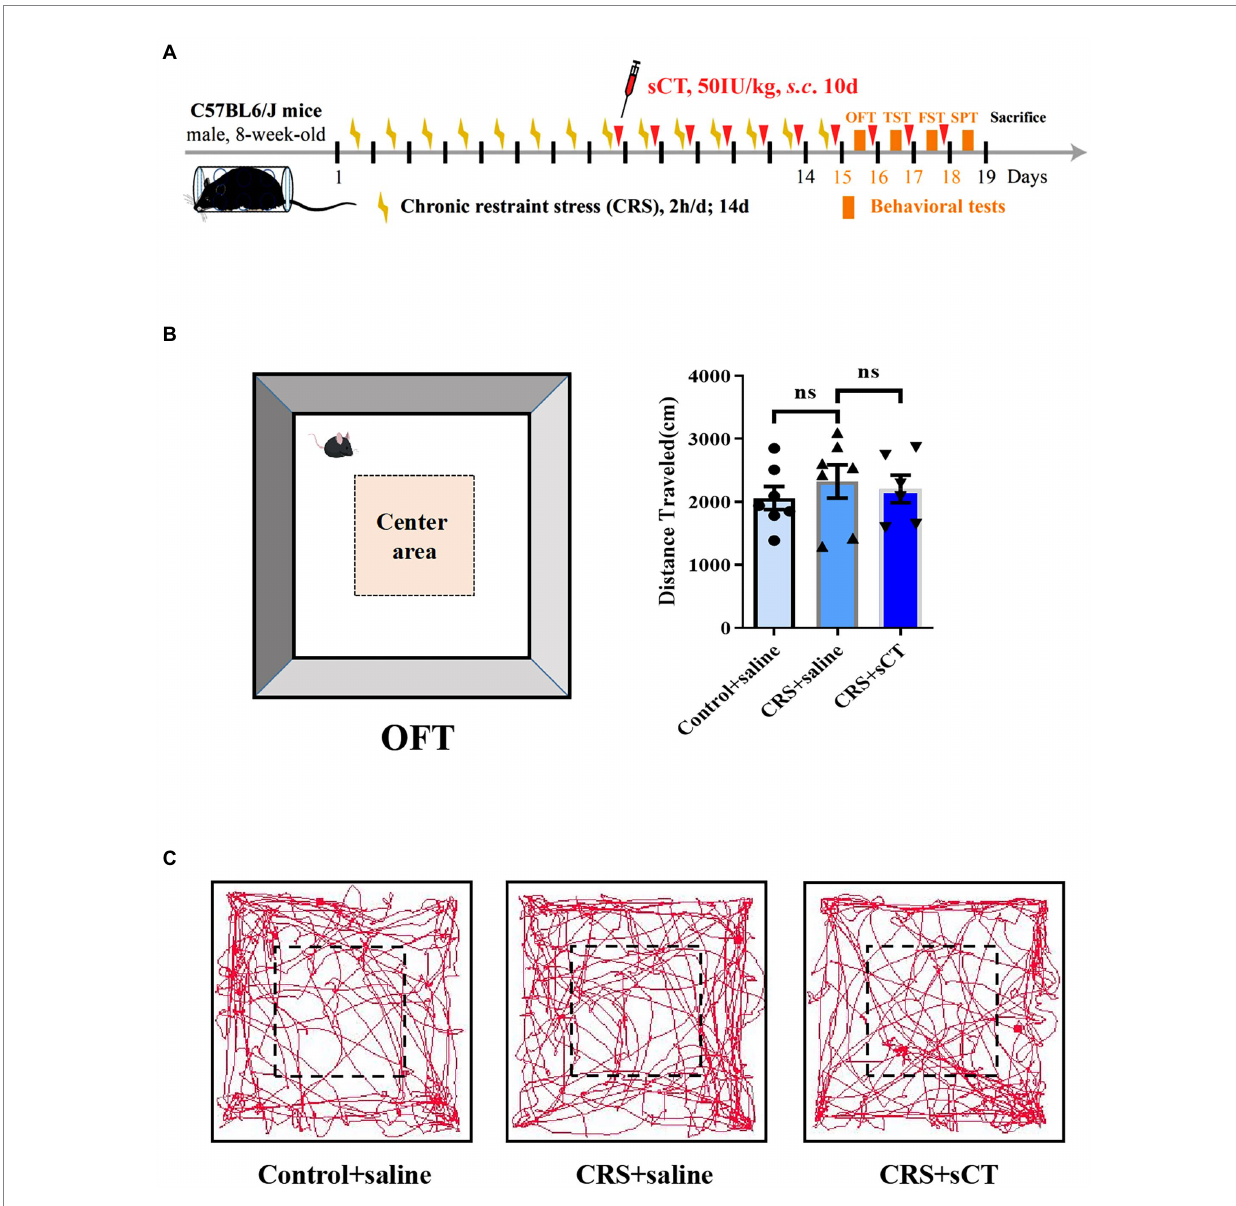
FIGURE 1 Locomotion level did not change in CRS-treated mice. (A) Schematic diagram showing experimental procedures of the CRS-treated mice model. (B) The distance traveled in OFT did not change in CRS-treated mice (Control + saline: n = 7; Depression + saline: n = 7; Depression + sCT: n = 6). (C) Representative images of movement trace in OFT. The data were analyzed by one-way ANOVA with Tukey’s multiple comparison tests. ns, no